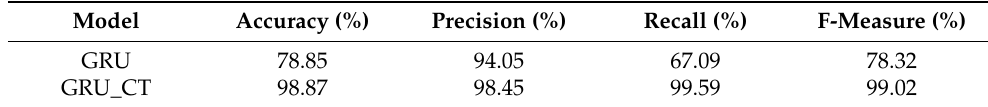
Table 8. The performance of GRU model with and without confidence threshold.